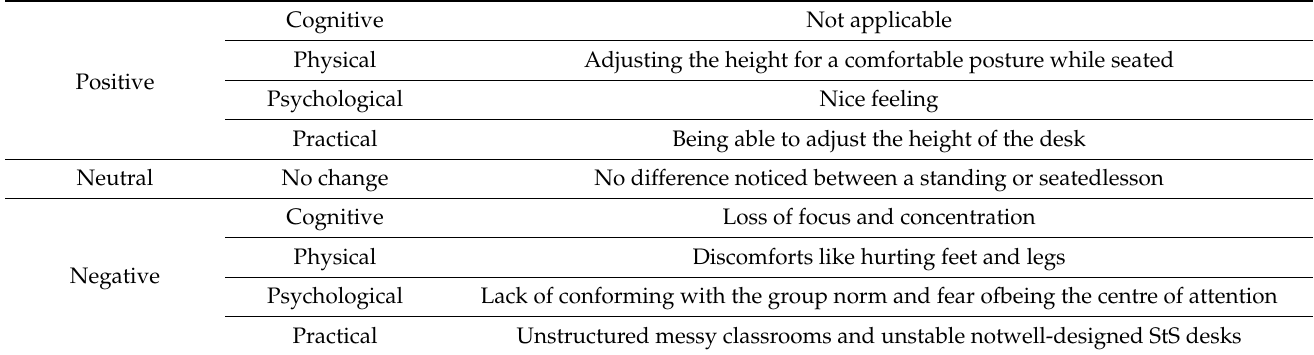
Table 3. Summary of the results for theme 3: What did you experience while standing behind the desk. Cognitive Not applicable Physical Adjusting the height for a comfortable posture while seated Positive Psychological Nice feeling Practical Being able to adjust the height of the desk Neutral No change No difference noticed between a standing or seatedlesson Cognitive Loss of focus and concentration Physical Discomforts like hurting feet and legs Negative